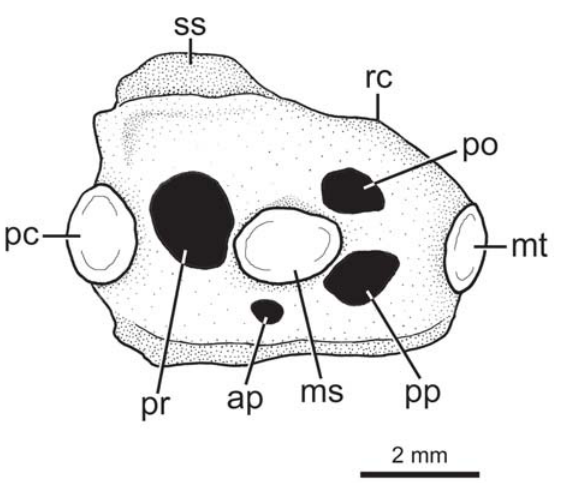
Fig. 13. Pelvic girdle of Malacoraja obscura , n. sp. in dors- oventral view (from radiographs). (a) adult female (MNRJ 28289, 680 mm TL, holotype); (b) subadult male (MNRJ 28291, 355 mm TL, paratype). Obturator foramina omitted in (b). An- terior toward